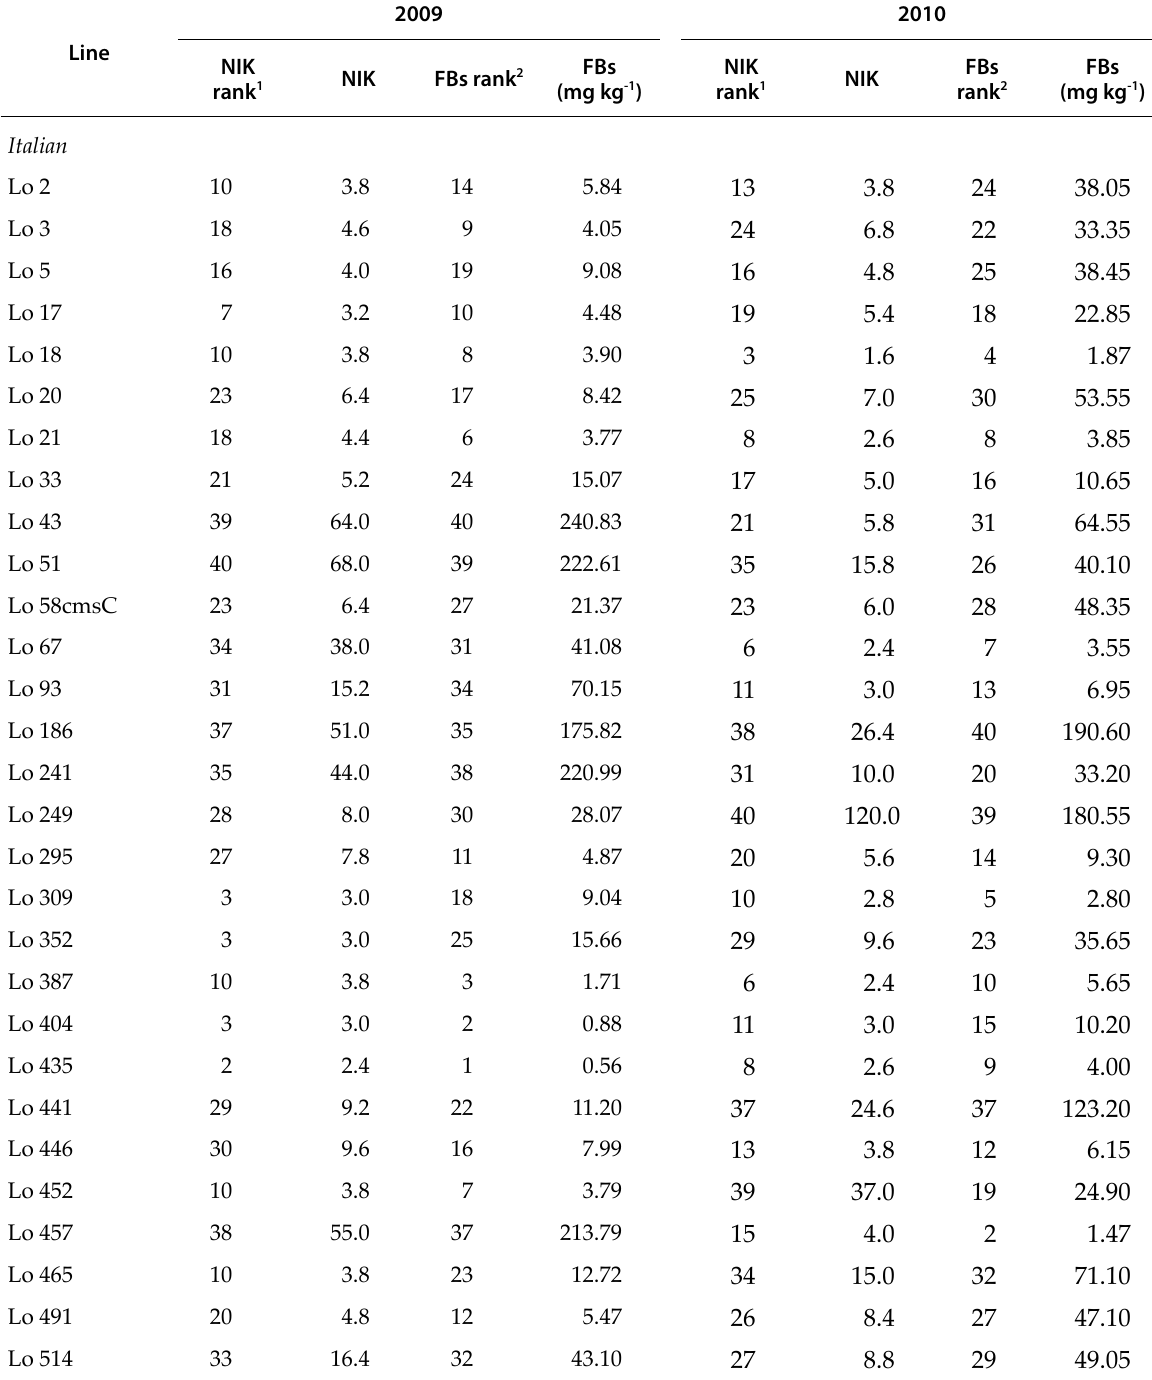
Table 2. Mean number of infected kernels at the inoculation point (NIK) and fumonisin concentration (FBs, mg kg -1 ) for the 40 maize inbred lines evaluated after F. verticillioides kernel inoculation (2009 and